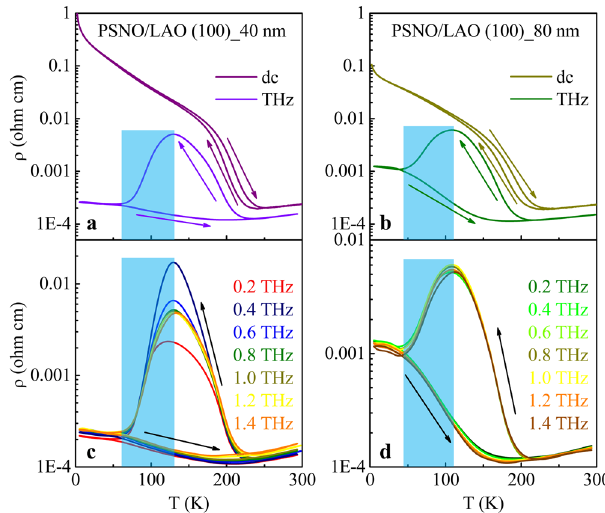
Fig. 3 Kinetically arrested phase transition. a , b Comparison of temperature-dependent resistivities obtained through dc transport and THz-TDS (at 1 THz). Arrows show heating and cooling sequences. The shaded region in THz conductivity shows kinetically arrested phase where the metallic phase reappears below T MI . The kinetically arrested phase is detectable at all the THz frequencies shown by the shaded region in c , d